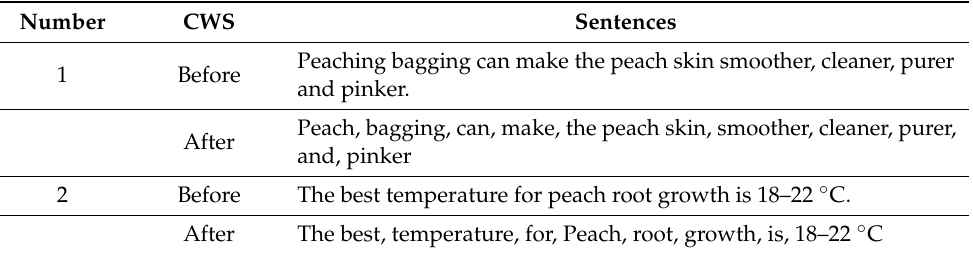
Table 6. Example of Chinese words segmentation.